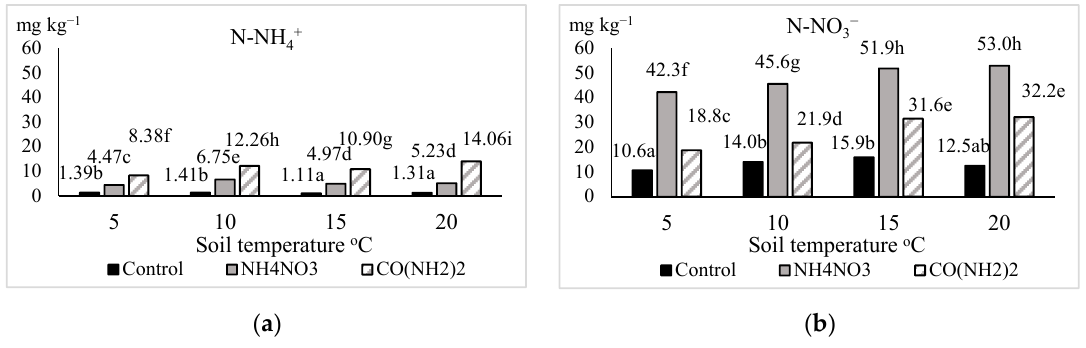
Figure 3. The influence of nitrogen fertilizers and ambient temperature on changes of ( a ) N-NH 4 + and ( b ) N-NO 3 − in the 0–15 cm soil layer with a simulated precipitation amount of 20 mm. Values followed by different letters are significantly different ( p ≤ 0.05) based on Fisher’s LSD test.